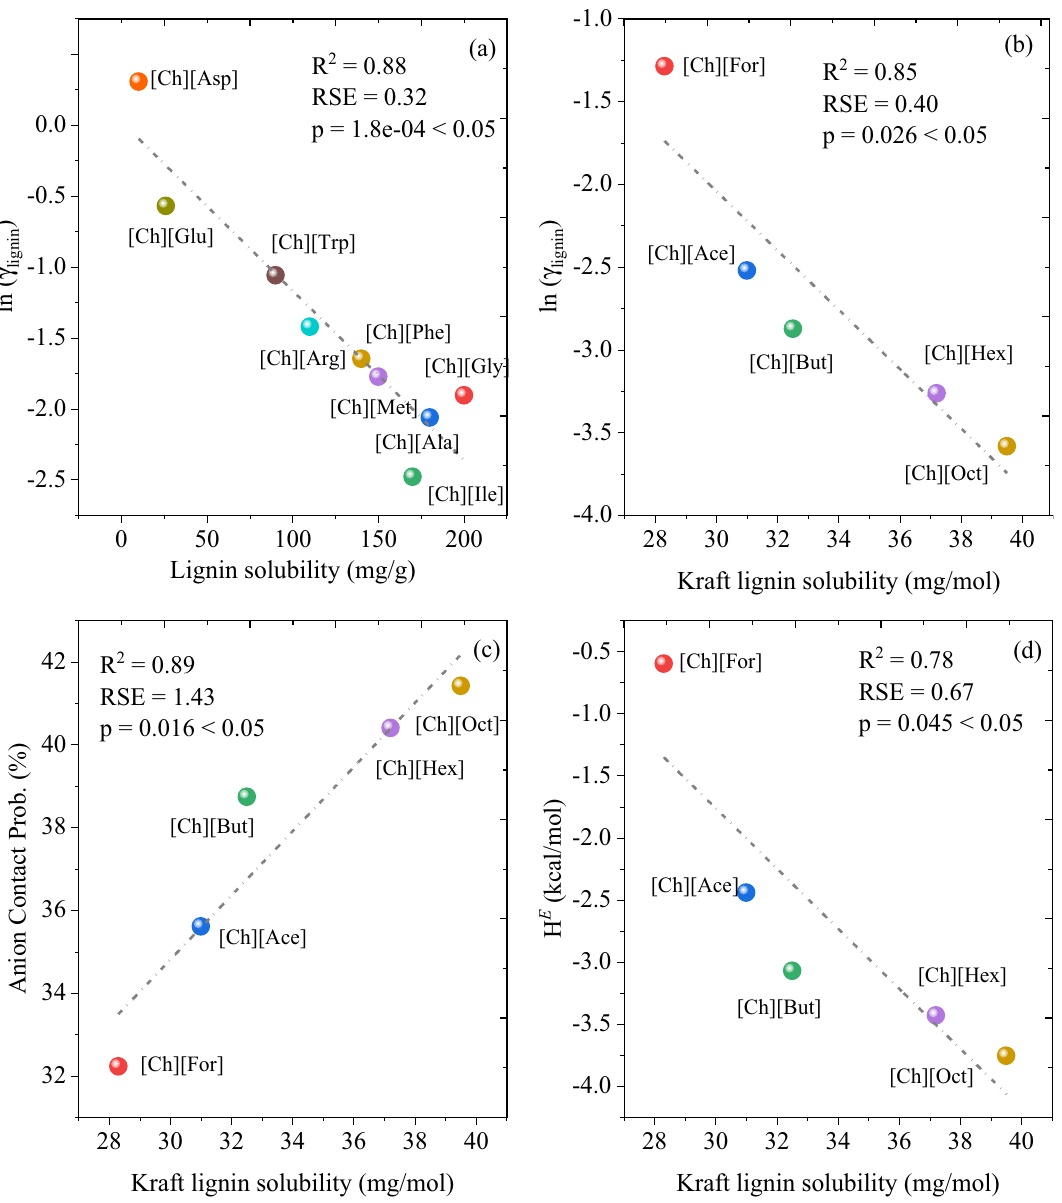
Figure 1. Correlation between the COSMO-RS predicted thermodynamic properties ( a , b ) logarithmic activity coefficient ( ln ( γ )) versus lignin solubility, ( c ) excess enthalpy, H E , versus lignin solubility, and ( d ) contact probability between lignin-anions versus experimental lignin solubility. COSMOTherm version 19.0.1 was used to calculate the ln ( γ ), H E , and contact probabilities (https:// www. 3ds. com/ produ cts- servi ces/ biovia/ produ cts/ molec ular- model ing- simul ation/ solva tion- chemi stry/ biovia- cosmo therm/). ( a ) Data taken from Lie et al. 61 and ( b – d ) data taken from Hou et al. 60